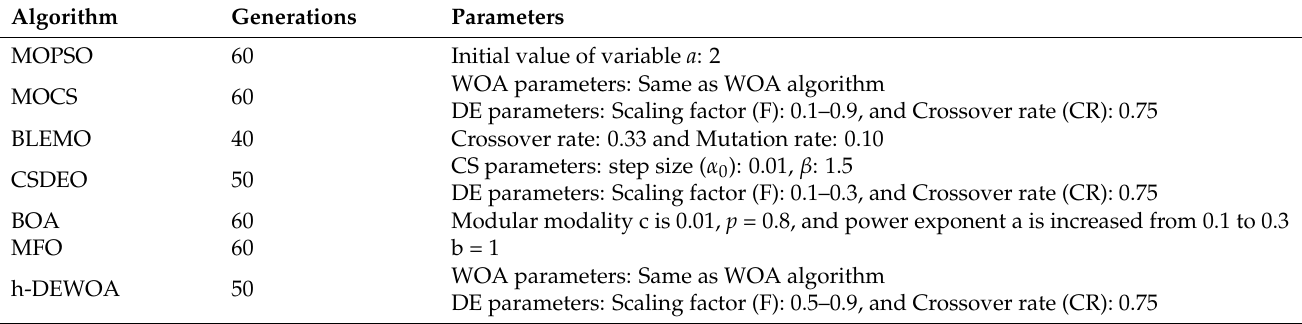
Figure 15. Convergence examination of scheduling algorithms with PopSize = 60 for CEA-Curie workload for the second series of experiments. Table 13. Parameter settings of algorithms for the second series of experiments for 30 independent executions of each algorithm.